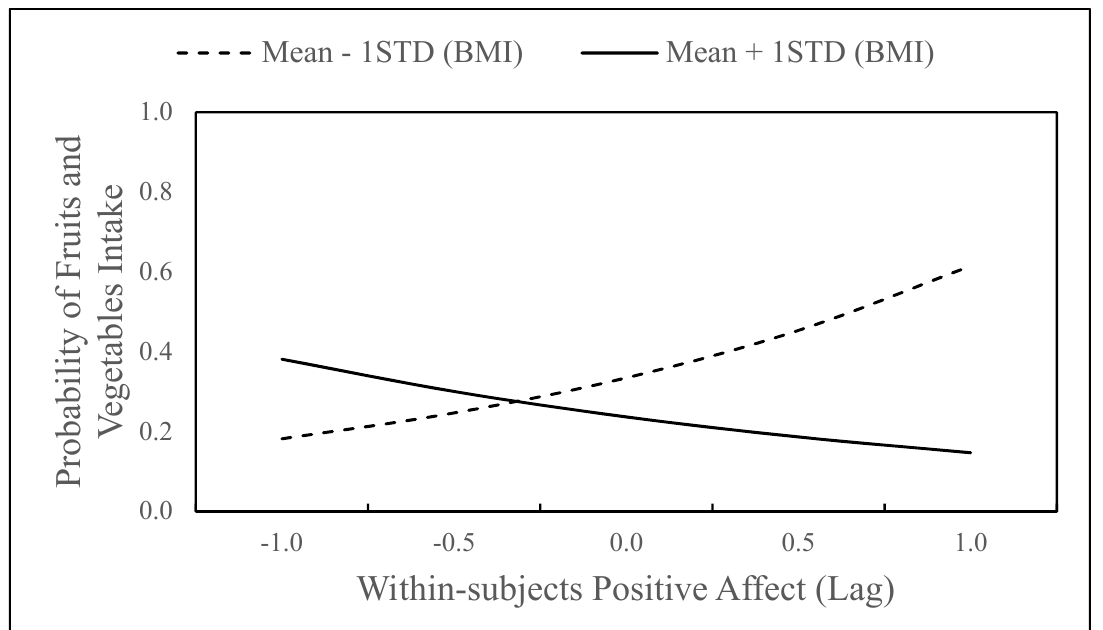
Figure 2. Two-way interactions of lagged within-subjects positive affect and pre-pregnancy BMI predicting intake of fruits and vegetables. The x-axis shows values of within-subjects positive affect with 0 representing one’s own average level of positive affect, positive values representing greater than one’s own average level of positive affect, and negative values representing lower than one’s own average level of positive affect. The y-axis represents the probability of fruit and vegetable intake.